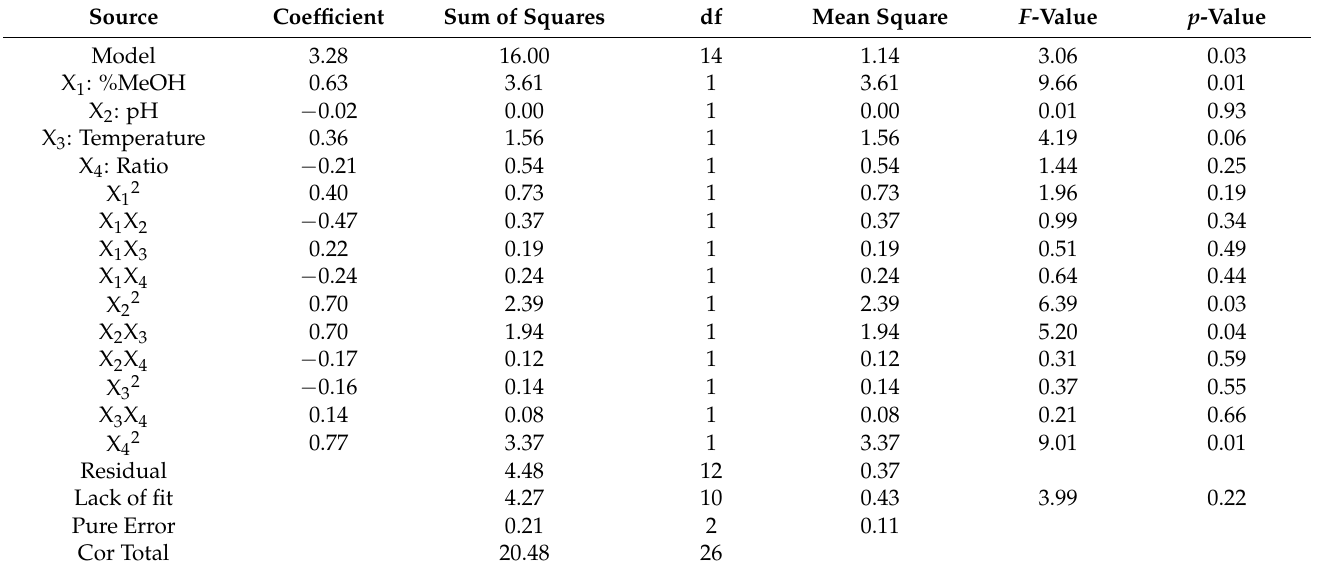
Table 3. ANOVA of the total phenolic compounds in the MAE